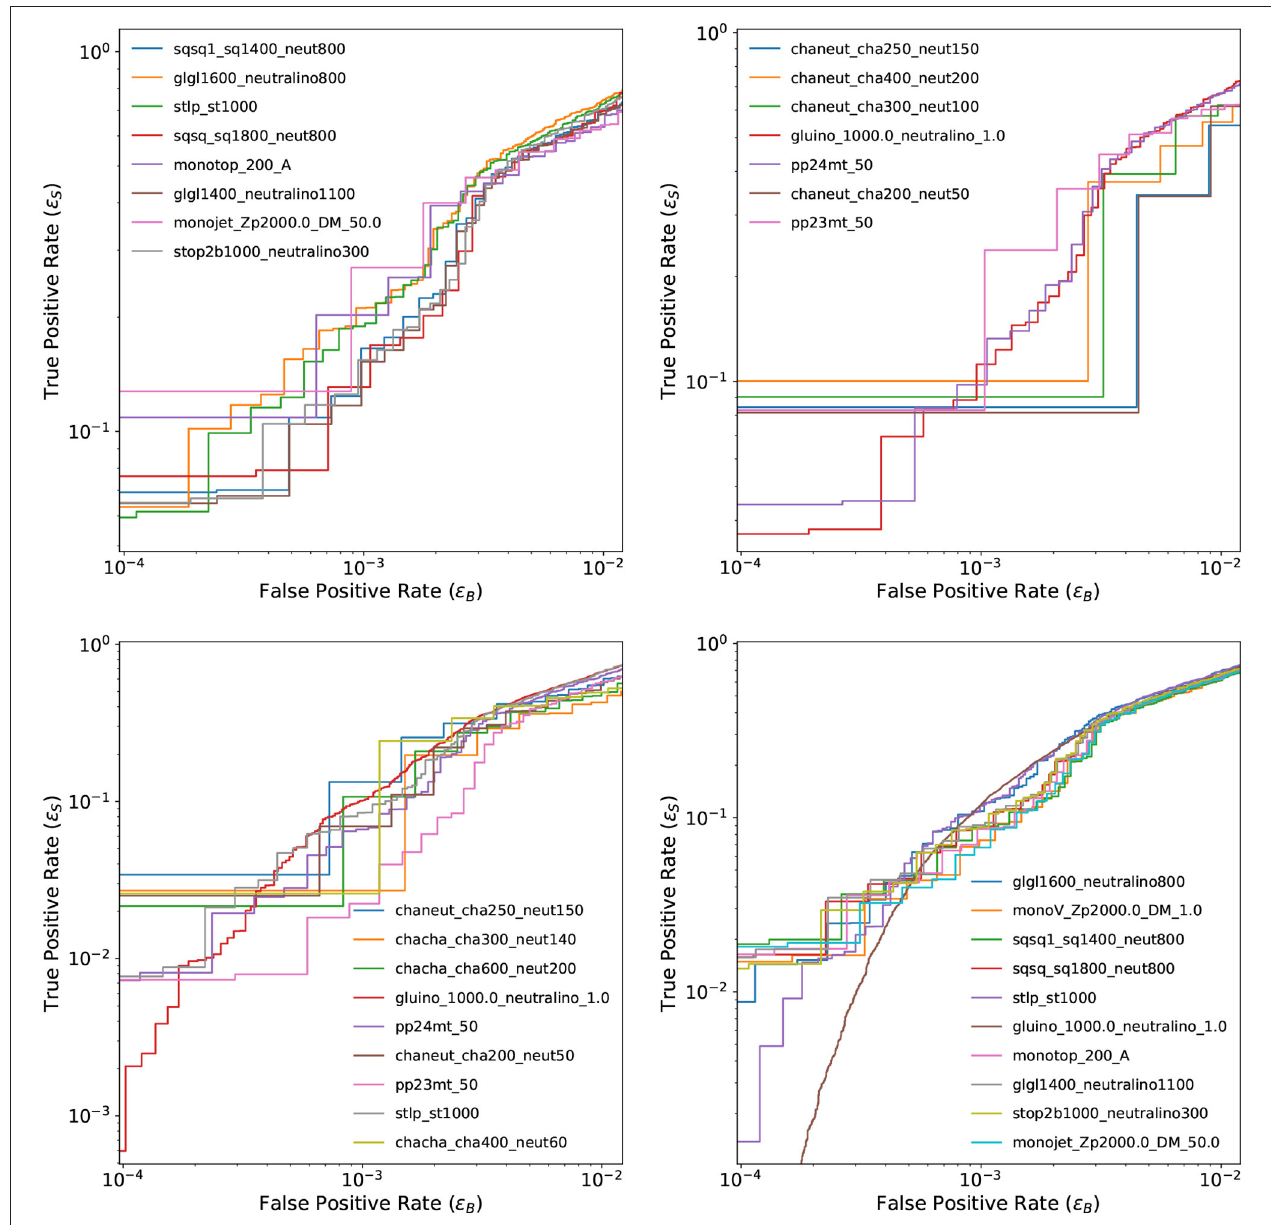
FIGURE 5 | ROC curves for the baseline GCN-VAE model in channel 1 (top left), channel 2a (top right), channel 2b (bottom left), and channel 3 (bottom right), computed from the ǫ S and ǫ B values obtained on the background sample and the benchmark signal samples. Most of the ROC curves are not smooth, due to the small dataset size for some of the